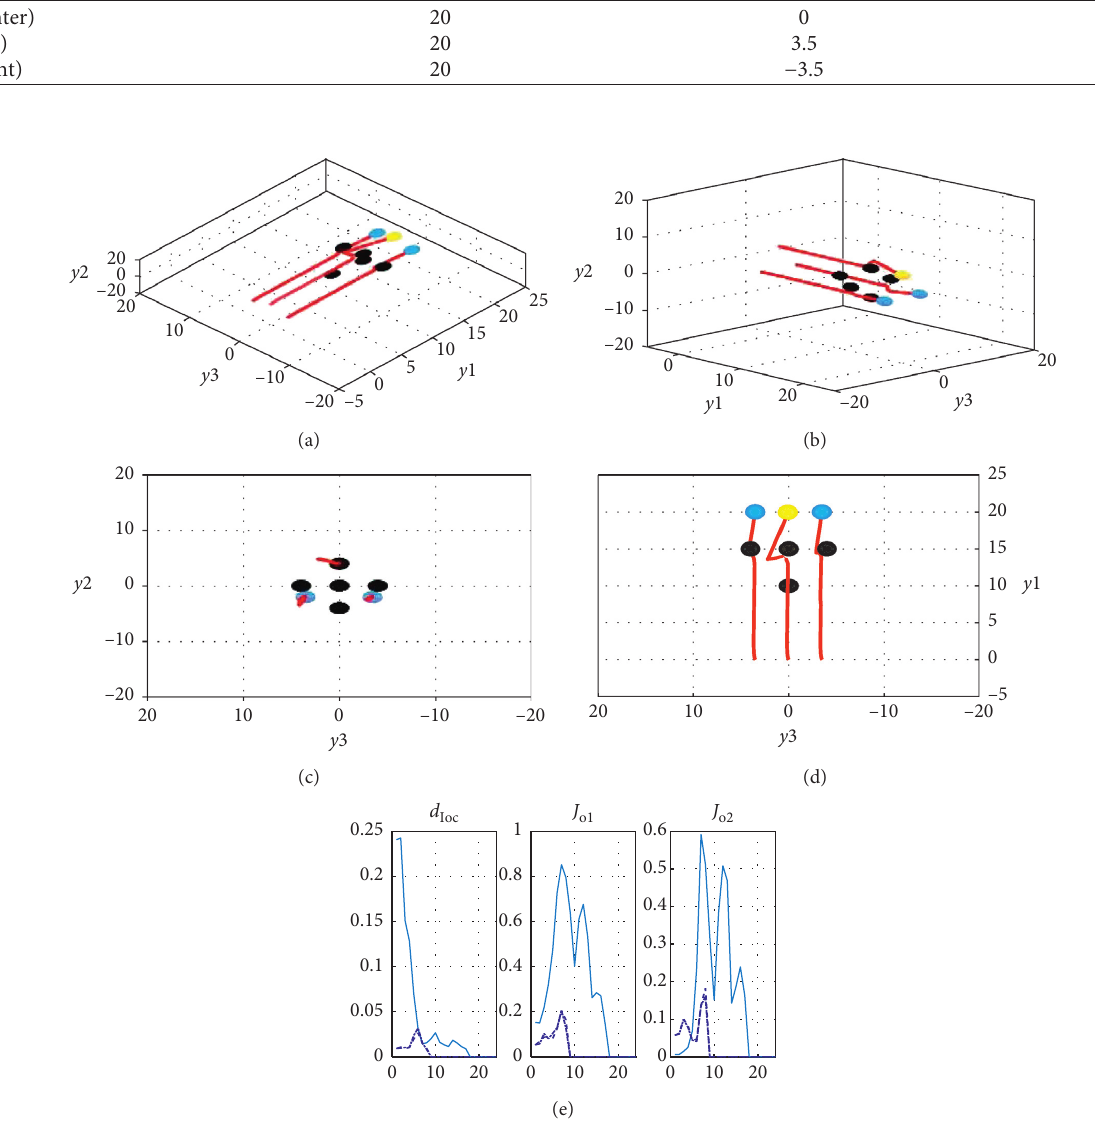
Figure 31: Case 1 simulation results. (a–d) Results of simulating the movement of a group of AMR when reaching the endpoint; (e) estimation of the complexity of the environment during